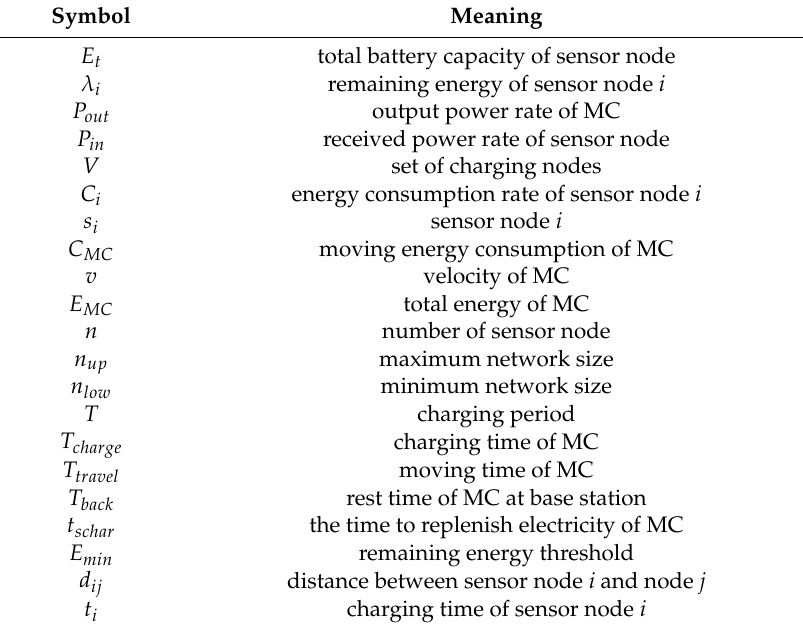
Table 1. Summary of